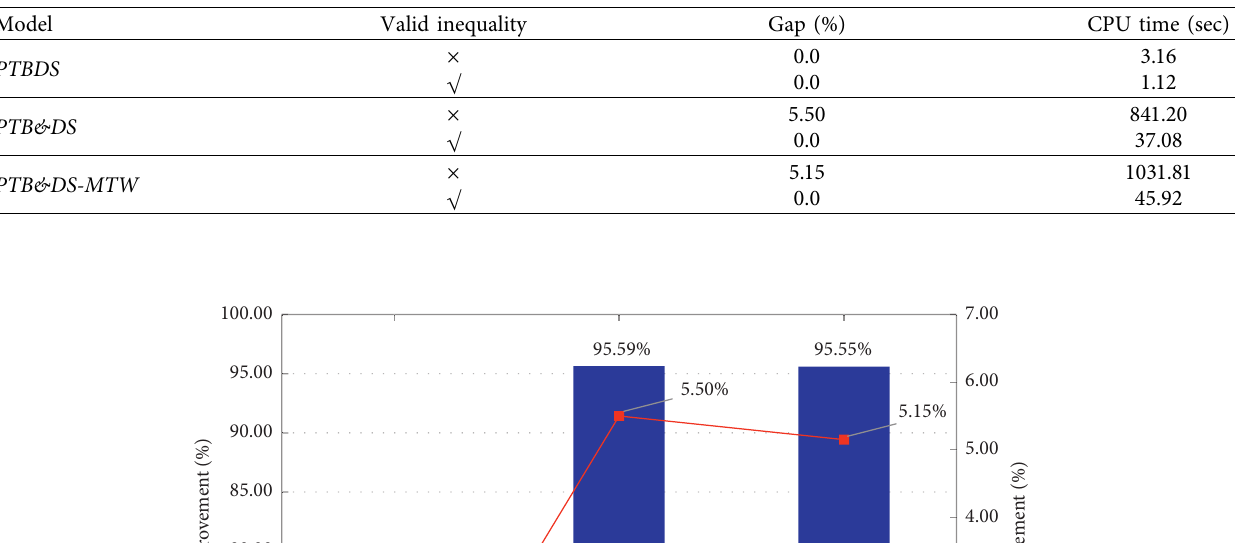
Table 5: Investigation of the valid inequality approach.